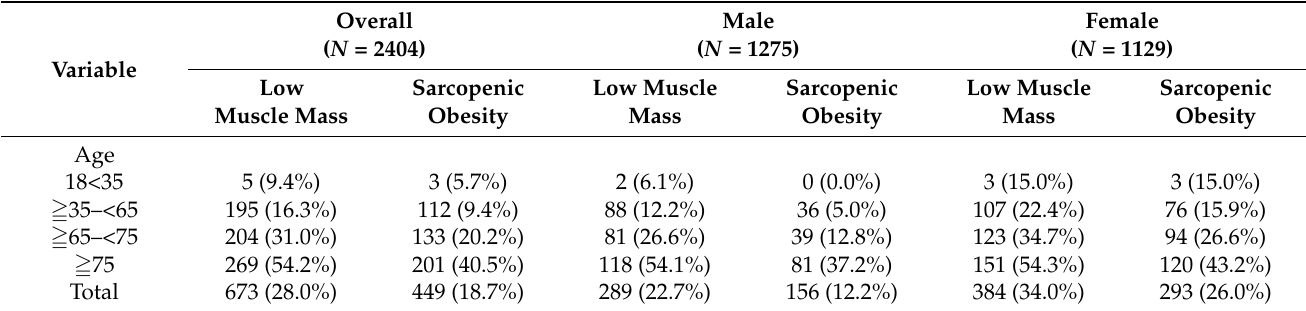
Table 2. Prevalence of low muscle mass and sarcopenic obesity among participants of different age groups.